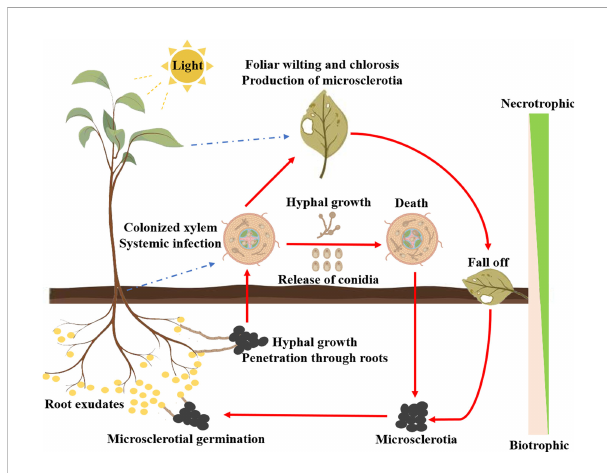
FIGURE 2 Infection cycle of V. dahliae in generic host